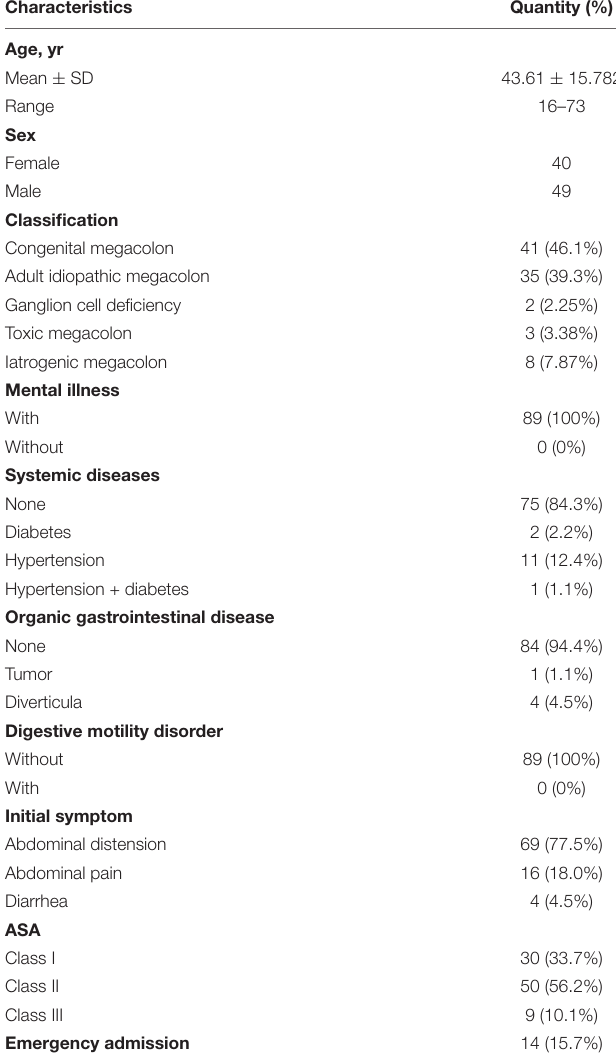
TABLE 1 | Patient